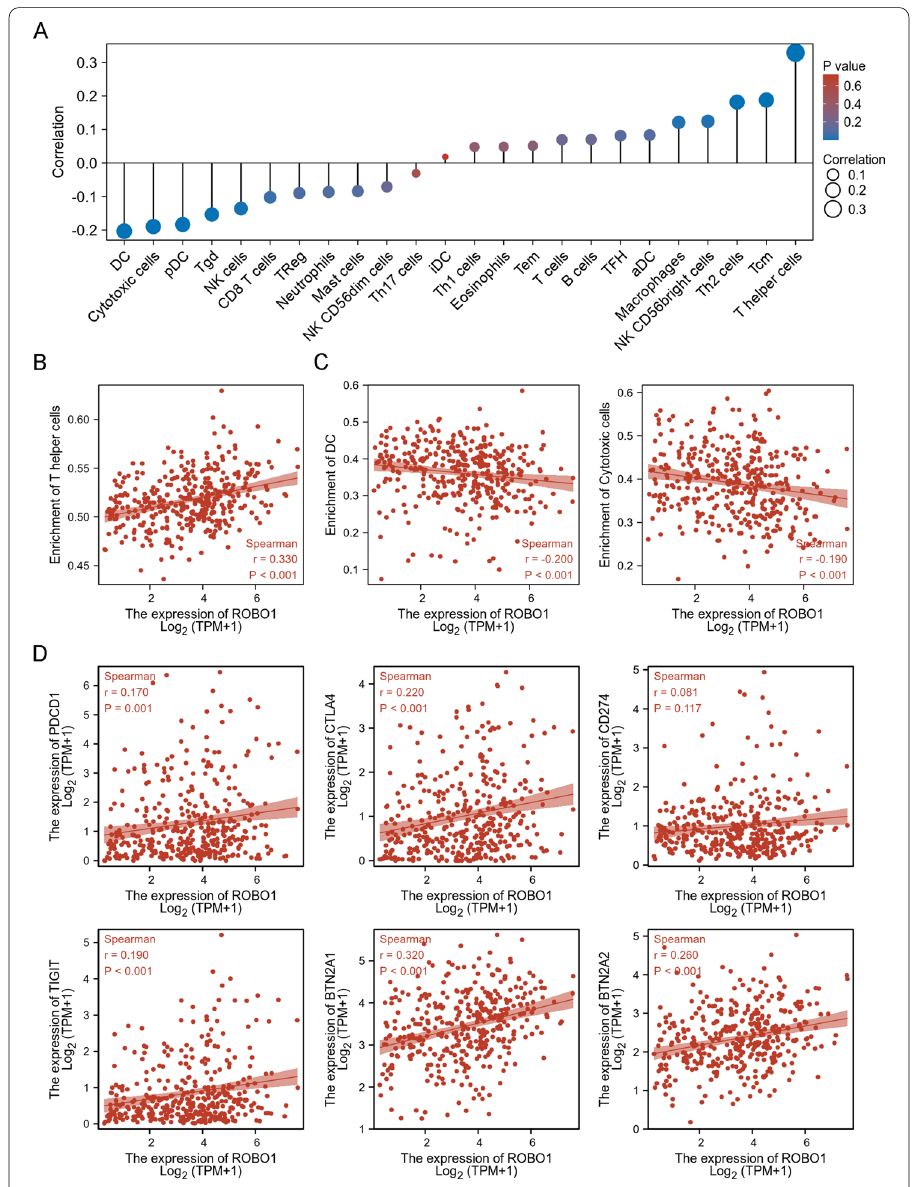
Fig. 4 The relationship of ROBO1 expression with tumour immunology. ssGSEA algorithm was implemented to explore the correlation between ROBO1 expression and immune cell enrichment in HCC tissues ( A ). Spearman correlation analysis evaluated the correlation of ROBO1 with T helper cells ( B ), DC and cytotoxic cells ( C) . Spearman correlation analysis evaluated the correlation of ROBO1 with 6 immune checkpoint molecules ( D